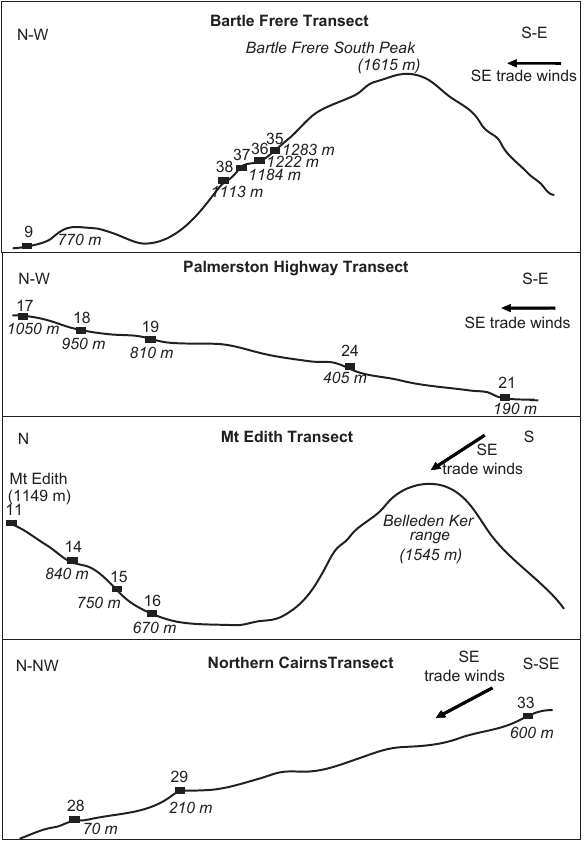
Fig. 3. The four sampled transects: topography and location rela- tively to the dominant S-E trade winds. Numbers refer to the sam- pled sites (Table